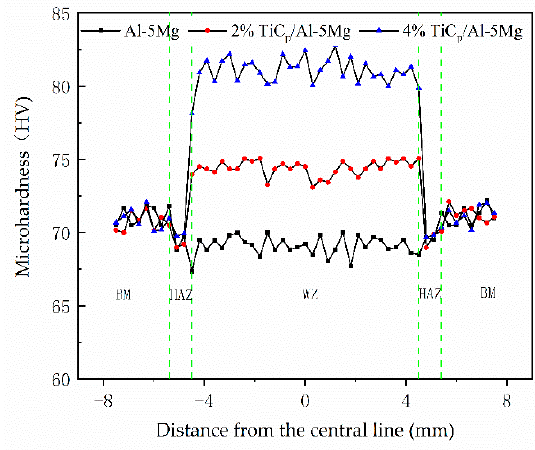
Figure 6. Microhardness distributions of the weld joints produced with different contents of TiC particles.